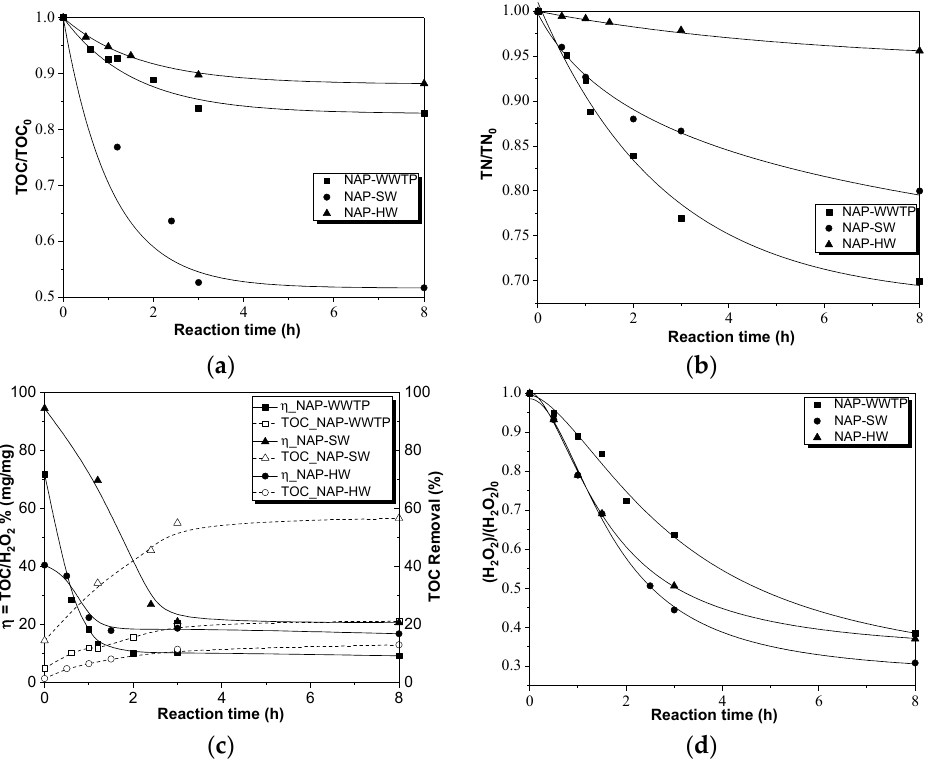
Figure 10. Degradation of the aqueous matrices spiked with NAP by CWPO; ( a ) evolution of total organic carbon (TOC) concentration; ( b ) evolution of total nitrogen (TN) concentration; ( c ) evolution of efficiency of hydrogen peroxide to TOC; ( d ) evolution of H 2 O 2 concentration. Reaction conditions: [NAP] 0 = 10 mg/L, pH = 5, [catalyst] = 1.0 g/L, [H 2 O 2 ] 0 = 1.5 mM, T = 70 °C.